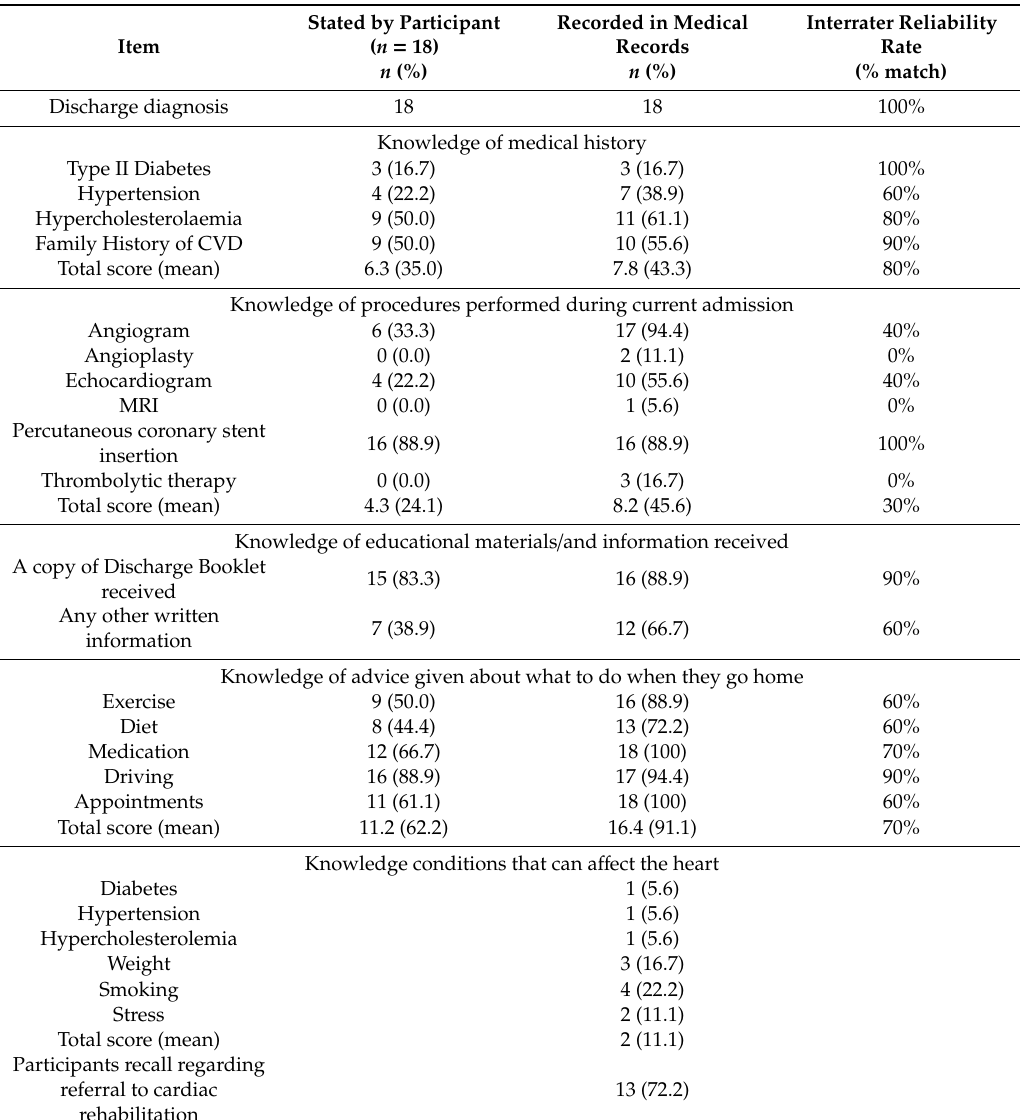
Table 4. Baseline knowledge of conditions & procedures & understanding of discharge